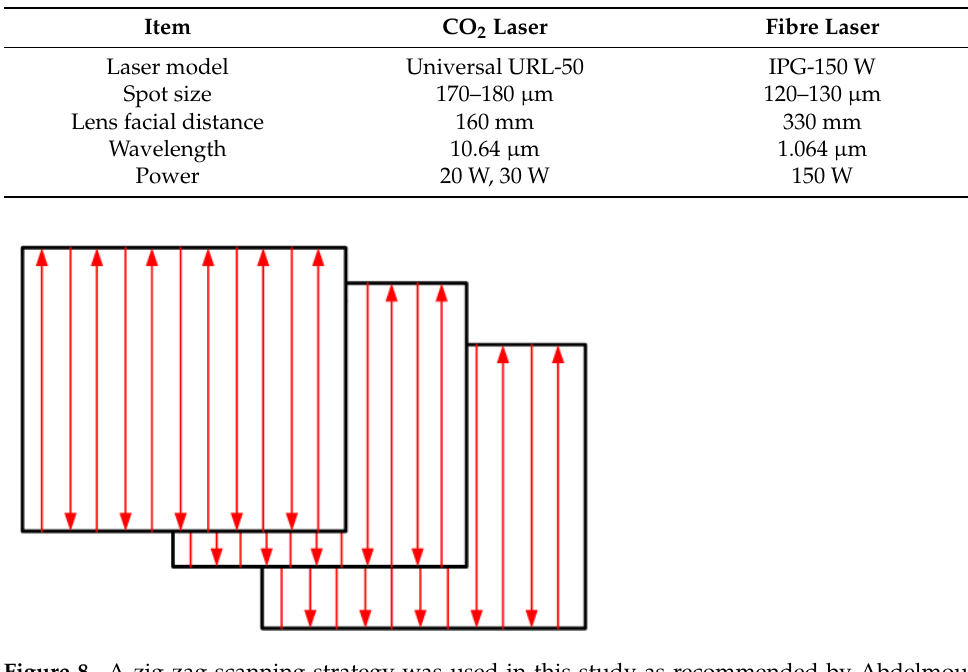
Figure 7. The developed experimental setup. Table 3. Laser sources specifications.